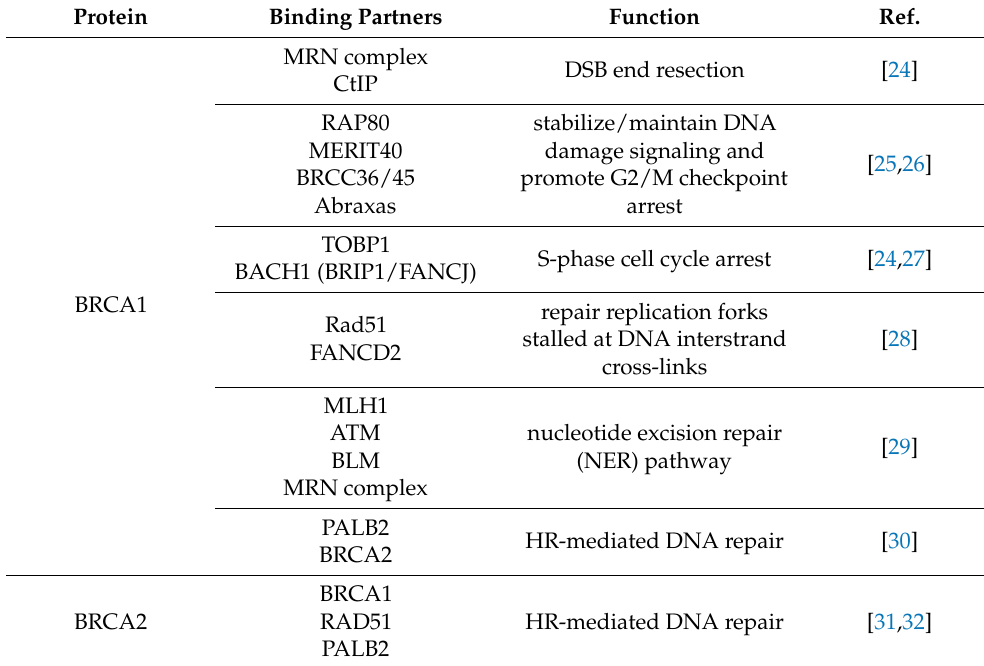
Table 1. List of proteins with which BRCA1 and BRCA2 interact and their role in DNA repair machinery. Protein Binding Partners Function